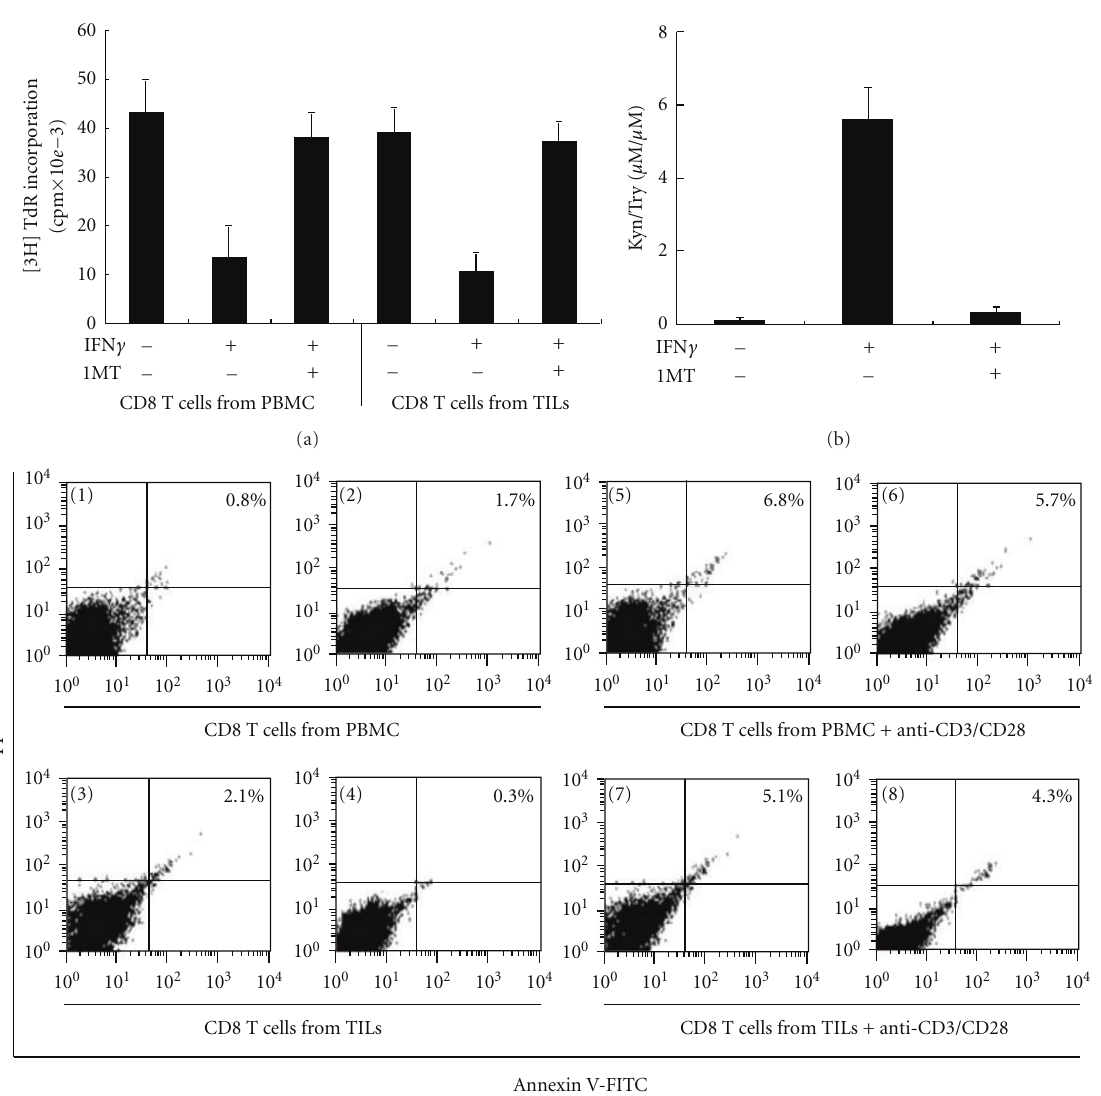
Figure 5: E ff ect of IDO on the proliferation and apoptosis of CD8 + T cells from both PBMCs and TILs. (a) Proliferation of CD8 + T cells from PBMCs or TILs was suppressed by IDO-expressing Eca109 cells. CD8 + T cells were cultured in conditioned media and activated with anti-CD3/CD28 antibodies. Proliferation of CD8 + T cells was assayed by [3H] TdR incorporation. (b) Concentrations of Kyn and Try were measured in the supernatants of Eca109 cells treated with or without IFN γ (50U/mL) and/or 1MT (100 μ M) for 24hr. Kyn and Try productions were analyzed by HPLC. (c) E ff ect of IDO on the apoptosis of CD8 + T cells from PBMCs or TILs. CD8 + T cells (1–4) or anti- CD3/CD28-activated CD8 + T cells (5–8) from both PBMCs and TILs were cultured in conditioned media derived from IFN γ -treated (2, 4, 6, 8) or untreated (1, 3, 5, 7) Eca109 cells for 4d, and the population of apoptotic cells was detected by flow cytometric analysis, using Annexin V and Propidium Iodide as indicators. Columns, mean of three independent experiments. Bars, SD. ∗ P < 0.05 compared with CD8 + T cells cultured in conditioned media derived from non-IFN γ -treated Eca109